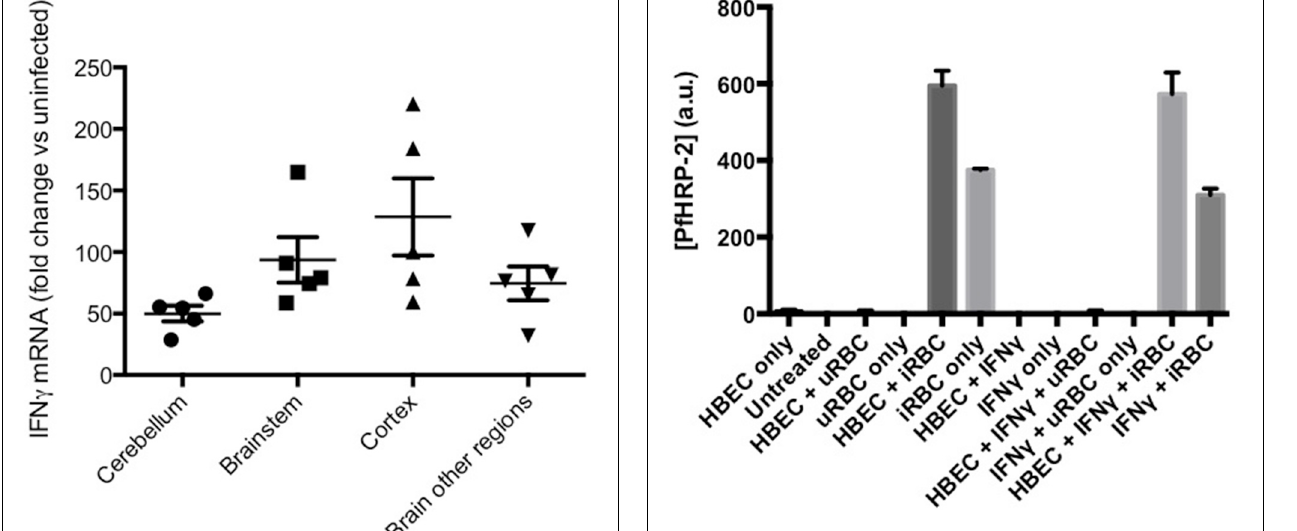
FIGURE 6 | IFN- γ mRNA in various brain regions in murine cerebral malaria. C57BL/6 mice were inoculated with 2 × 10 5 PbA-PRBC, their brains removed on day 6 post-inoculation and dissected into regions prior to homogenization. RT-PCR was performed as described elsewhere (50). Horizontal lines and vertical bars are mean ± s.e.m. of fold differences vs. equivalent samples from uninfected mice.